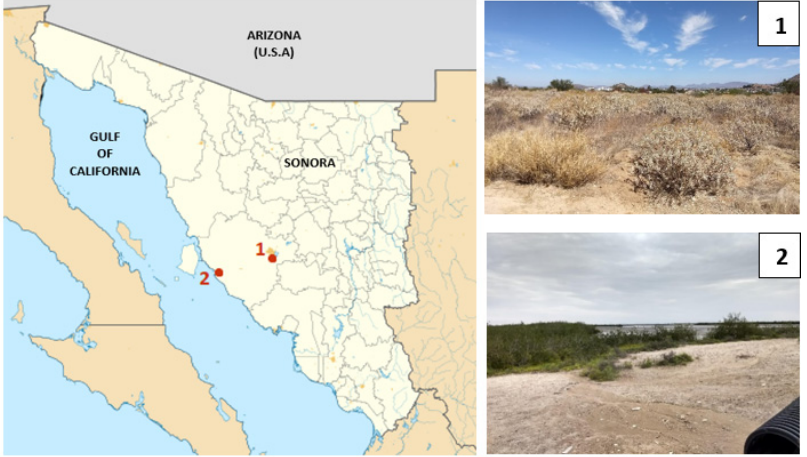
Figure 1. Sampling sites in the Sonoran Desert. Red dots show the location of each site: ( 1 ) Hermosillo (HMO) and ( 2 ) Kino Bay (KB).